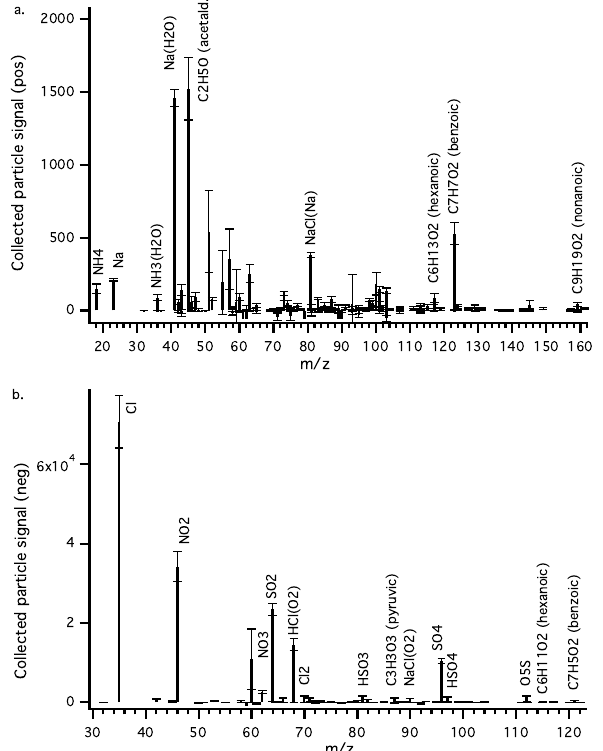
Figure 5. Campaign-averaged high resolution mass spectra of par- Fig. 5. Campaign-averaged high resolution mass spectra of particle composition in (a.) positive and ticle composition in (a) positive and (b) negative ion modes, mea- (b.) negative ion mode, measured by TDCIMS. This is an average of all background-corrected points sured by TDCIMS. This is an average of all background-corrected from May 18- 29, and one standard error bars are plotted. Ion identities for species which were at least points from 19 to 29 May, and one standard error bars are plotted. occasionally detectable are given. Ion identities for species which were at least occasionally detectable are given.